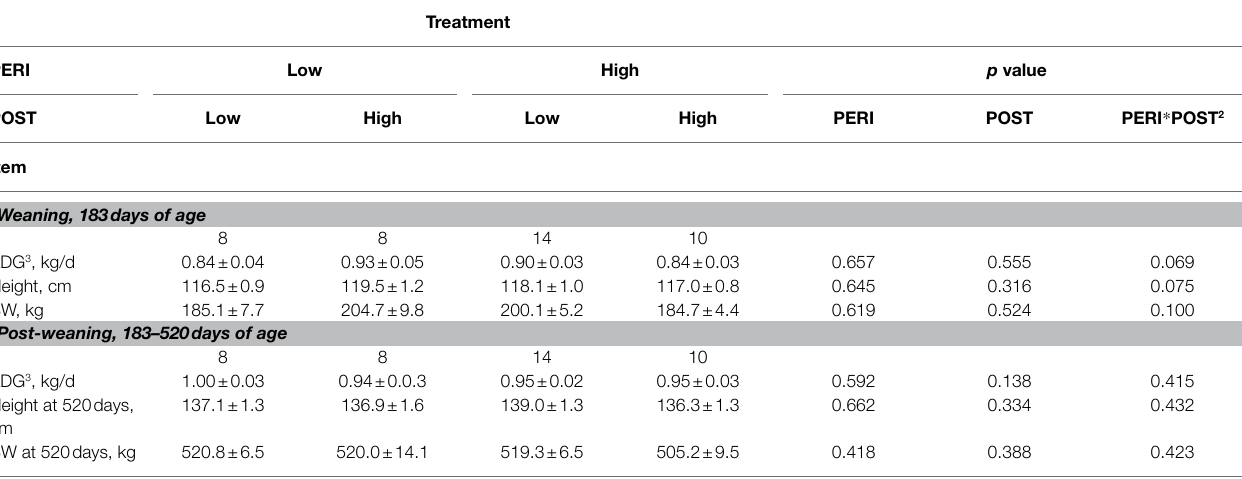
TABLE 2 | Liveweight (BW), height, and ADG of bulls at weaning and post-weaning prior to commencement of residual feed intake test, following exposure to maternal diets low or high in protein during the peri-conception and first trimester periods of gestation 1 .